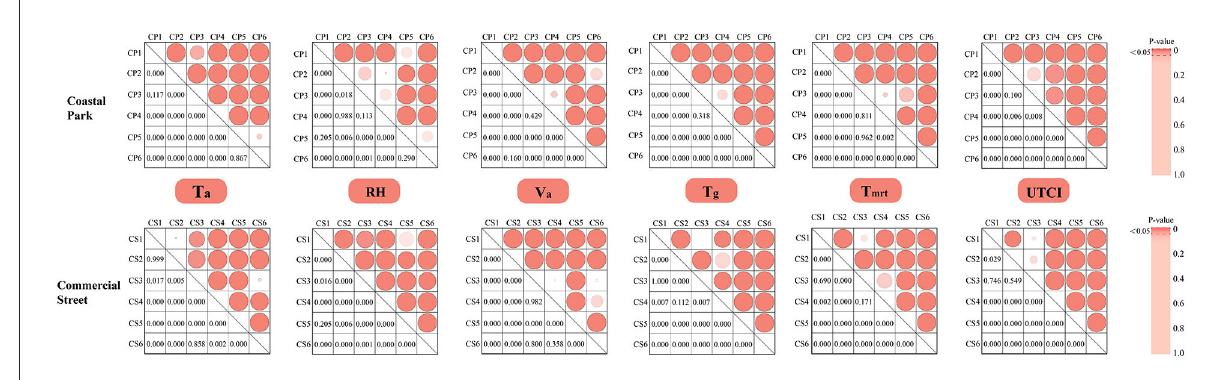
FIGURE3 Results of post-hoc Tukey’s test for different pairs of measurement points for the meteorological variables considered in this study.